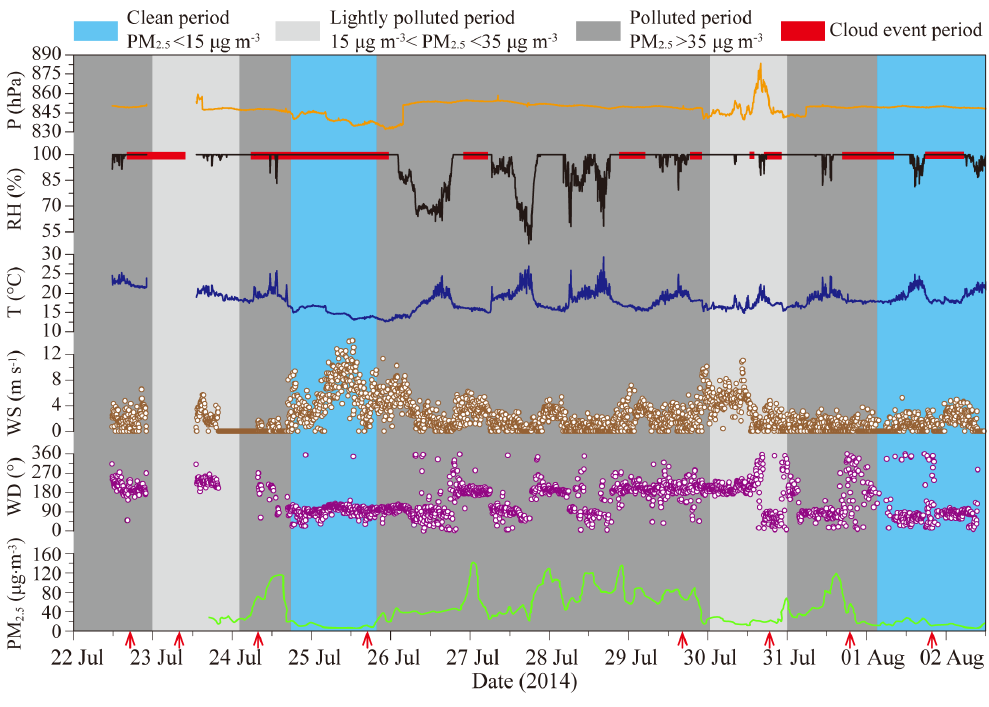
Figure 3. Temporal variations of pressure ( P ), relative humidity (RH), temperature ( T ), wind speed (WS), and wind direction (WD) measured on Mt. Tai from 22 July to 2 August 2014. The red arrows indicate collection times of individual particle samples during the cloud